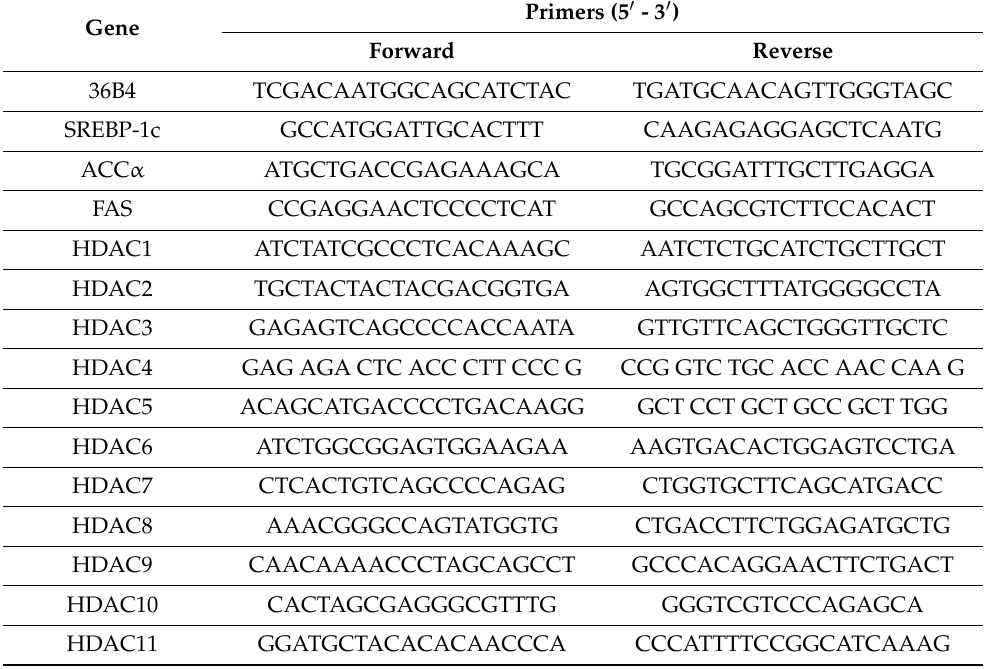
Table 1. Primer sequences for quantitative real-time